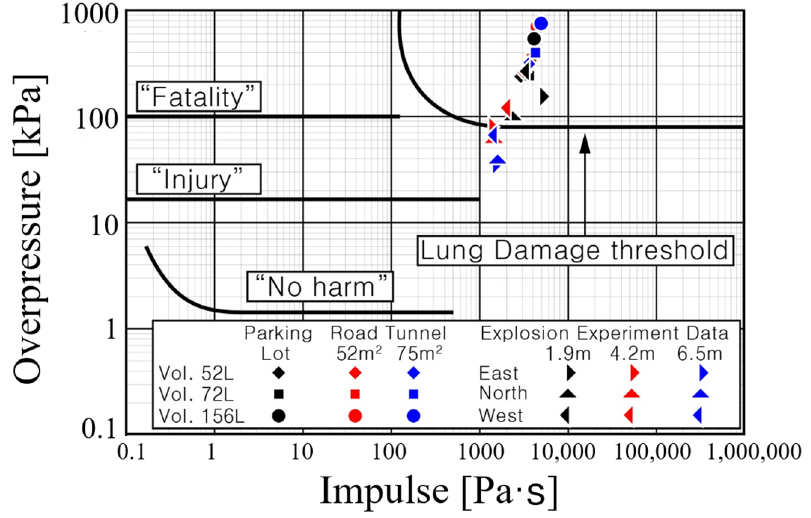
Figure 20. Comparison of overpressure–impulse curves (harm criteria for humans).